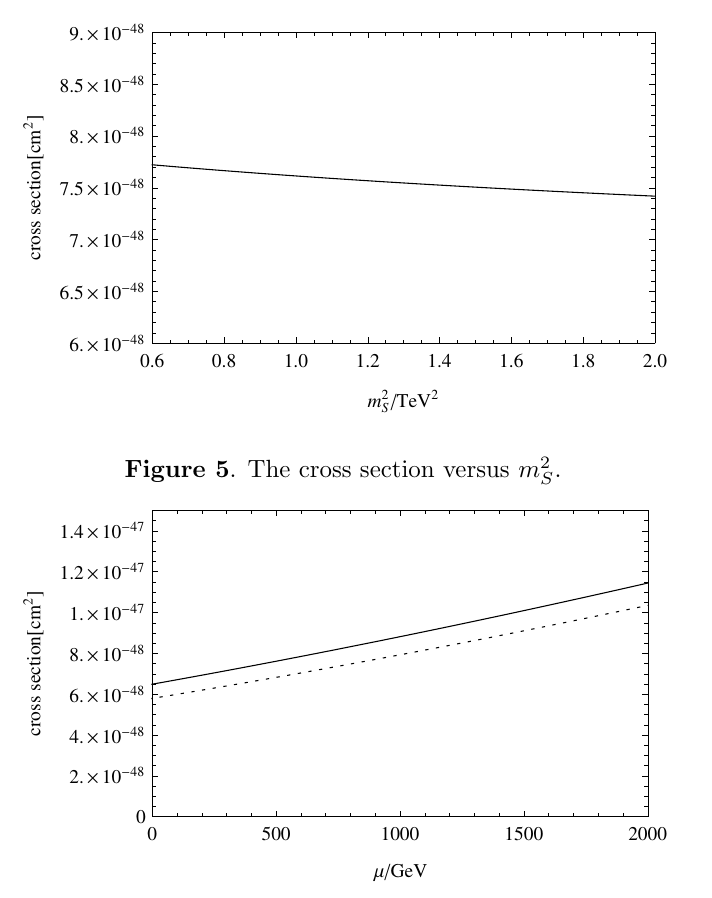
Figure 6 . The cross section versus (cid:22) is plotted by solid line (dotted line) with T (cid:23) 33 = 1 : 6 (1 : 4) TeV.